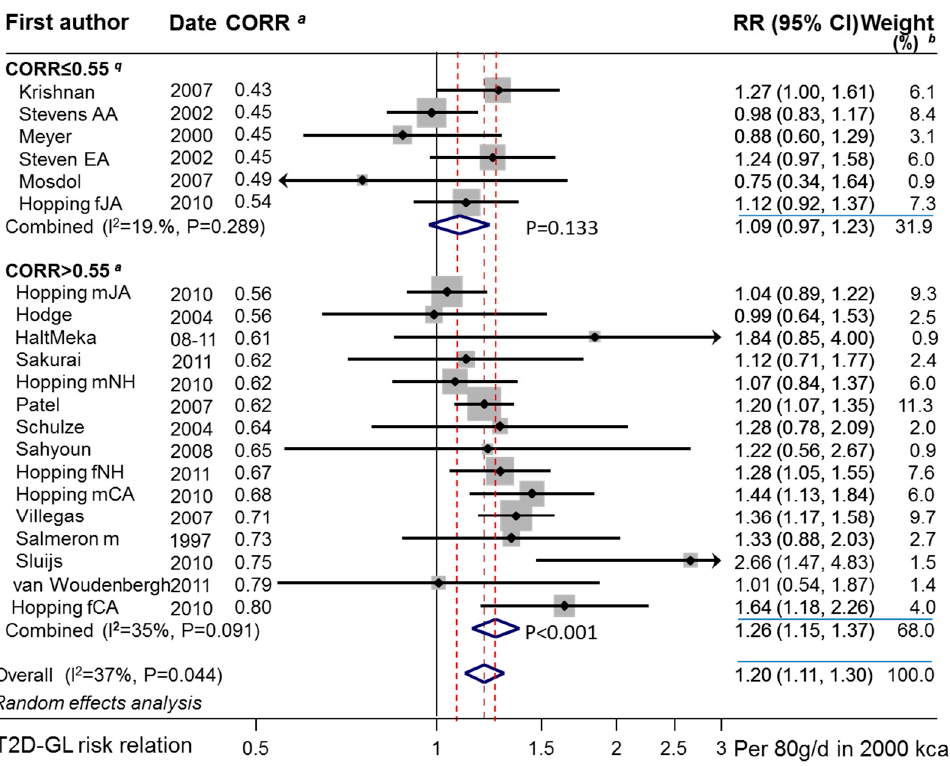
Figure 7. Forest plot of the dose-response T2D–GL risk relation by the validity of the dietary instrument. The box sizes are proportional to the weight contributed by the study to the combined-study mean. Horizontal lines span the individual study 95% confidence intervals.